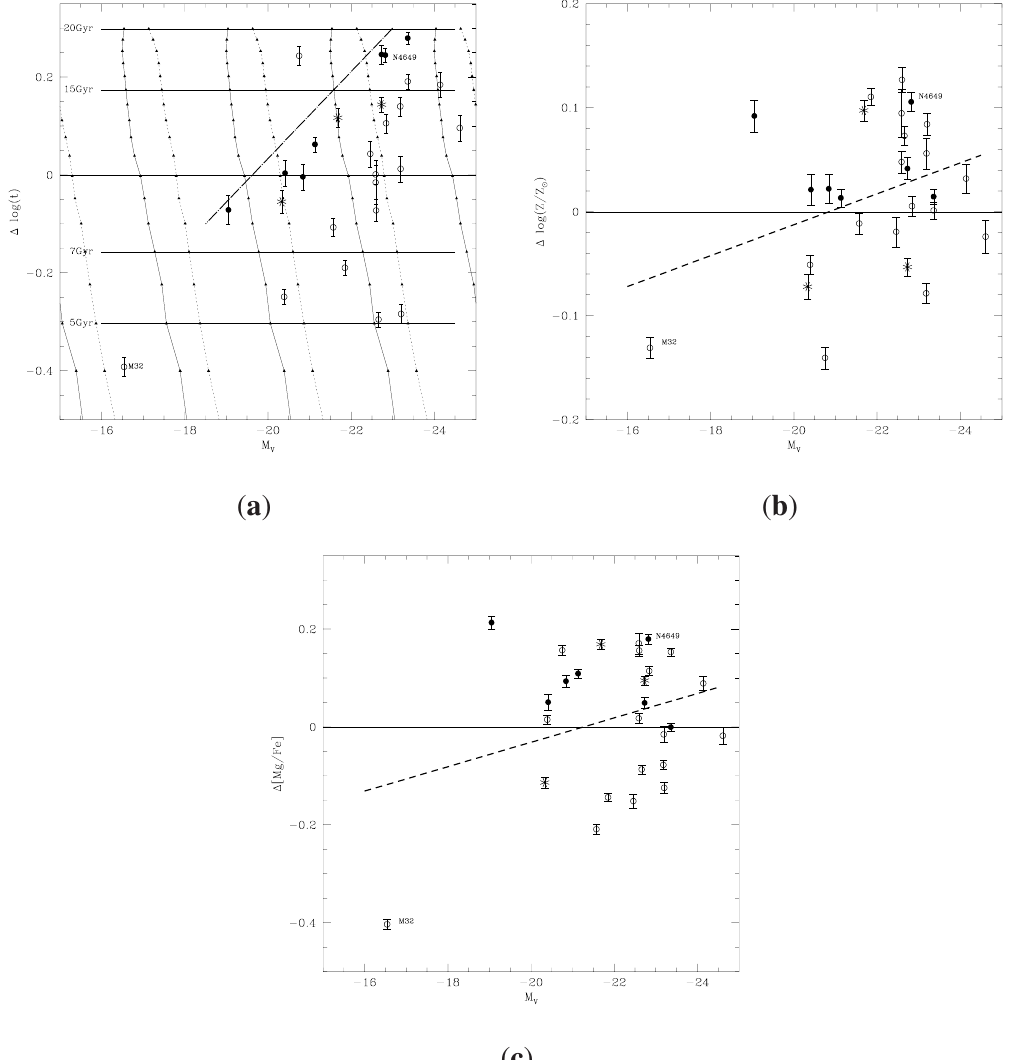
Figure 2. ( a ) The ∆ log(t) versus M relation. Filled circles are the galaxies defining the V age limit ( i.e. , those with no sign of dynamical rejuvenation, see the text for details), the heavy stars are the three galaxies of this group belonging to the Virgo cluster, and the open circles are all remaining galaxies. The eye drawn long-dashed-dotted line is only meant to visualize the age limit. Finally, the position of M32, NGC 4649 is indicated. Superposed to this diagram are the fading lines of SSPs: the thin dotted and solid lines are for Z = 0.004 and Z = 0.05, respectively; each dot along the lines marks the age in step of 1 Gyr starting from 20 Gyr (top) down to 4 Gyr (bottom); the thin horizontal lines locate the loci of constant age (20, 15, 10, 7, and 5 Gyr starting from the top). Finally, the fading lines of SSP (in pairs because of the different metallicity) are shown for different values of the total mass, namely from right to left; ( b ) The ∆ log(Z / Z 10 12 , 10 11 , 10 10 , 10 9 , and 10 8 M ) versus M V × ⊙ ⊙ relation. The thick dashed line is the linear regression of the results. All other symbols are as in the Top Left Panel. The position of M32 and NGC 4649 is indicated; ( c ) the same as in the Top Right Panel but for the ∆[Mg / Fe] versus M relation. The thick dashed line is V the linear regression of the results. (Reproduced with permission from [42]. Copyright 1998 Astronomy and